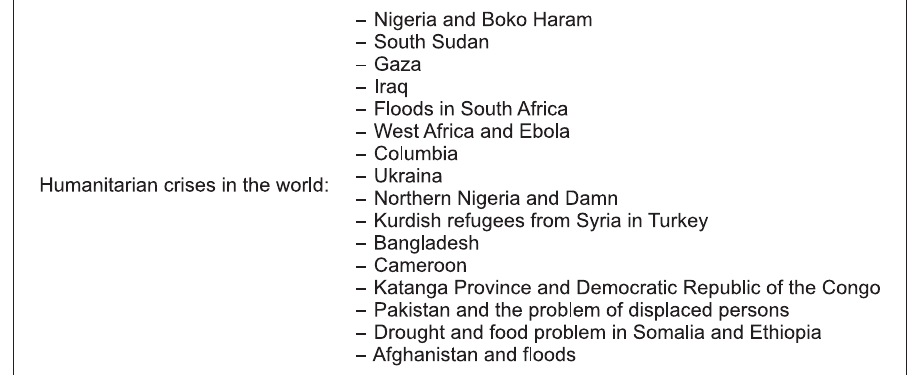
Source: own study based on: Crisis Briefings , http://www.globalhumanitarianassistance. org/crisis-briefings, 04.03.2021.